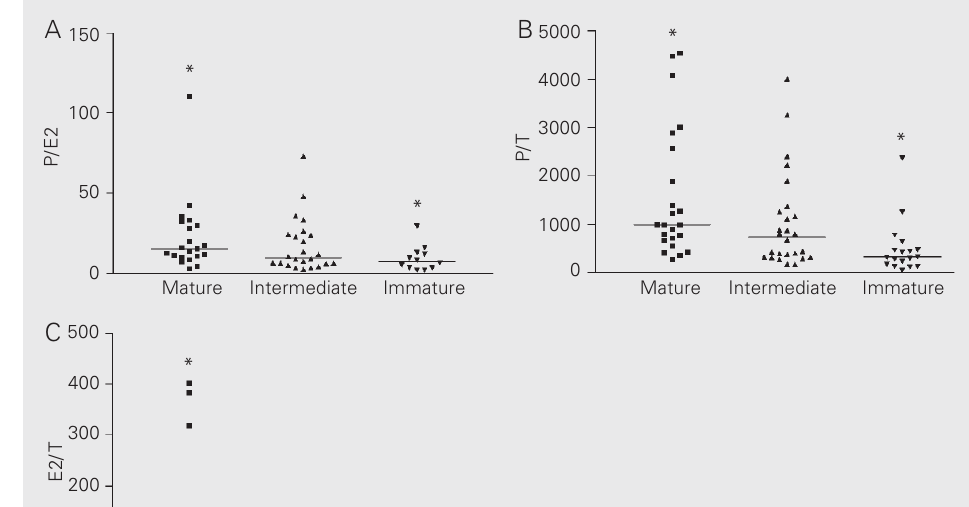
Figure 2. Sensitivity and speci- ficity relation for measurements of estradiol and testosterone in follicular fluid (receiver-operat- ing characteristic curve) as a cut- off point for the identification of mature oocytes. A , Estradiol: cut-off value = 505.8 ng/ml, with 81.0% sensitivity and 81.8% specificity. B , Testosterone: cut- off value = 10.4 ng/ml, with 90.9% sensitivity and 82.4% specificity.